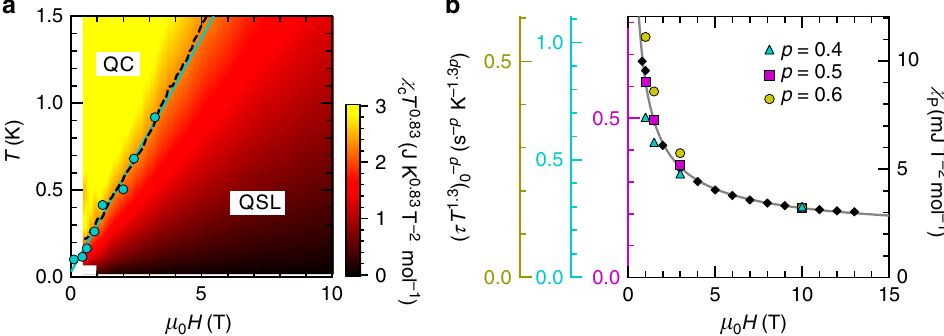
Fig. 4 Comparison of the MCE results with the susceptibility data. a Contour plot of the magnetic susceptibility multiplied by the power of temperature, χ T 0.83 , in the T – H plane, determined by us in ref. 16 . The yellow and dark-red areas represent the quantum critical (QC) and QSL states, respectively, which are separated by the crossover region (light-red area). The onset fi eld of the τ increase, H *, shown by the circles, falls on the contour line (dashed line), χ T 0.83 = 2.3 mJ K 0.83 T − 2 mol − 1 . The blue solid line indicates a linear fi t of H *. b The zero-temperature extrapolation of the ( τ T 1.3 ) − 1 values raised to the power p , ð τ T 1 : 3 Þ (cid:2) p , and the Pauli-like susceptibility, χ P , as a function of magnetic fi eld. χ P is determined based on the susceptibility data in ref. 16 . The solid 0 line represents a power-law fi t of χ P with the exponent −